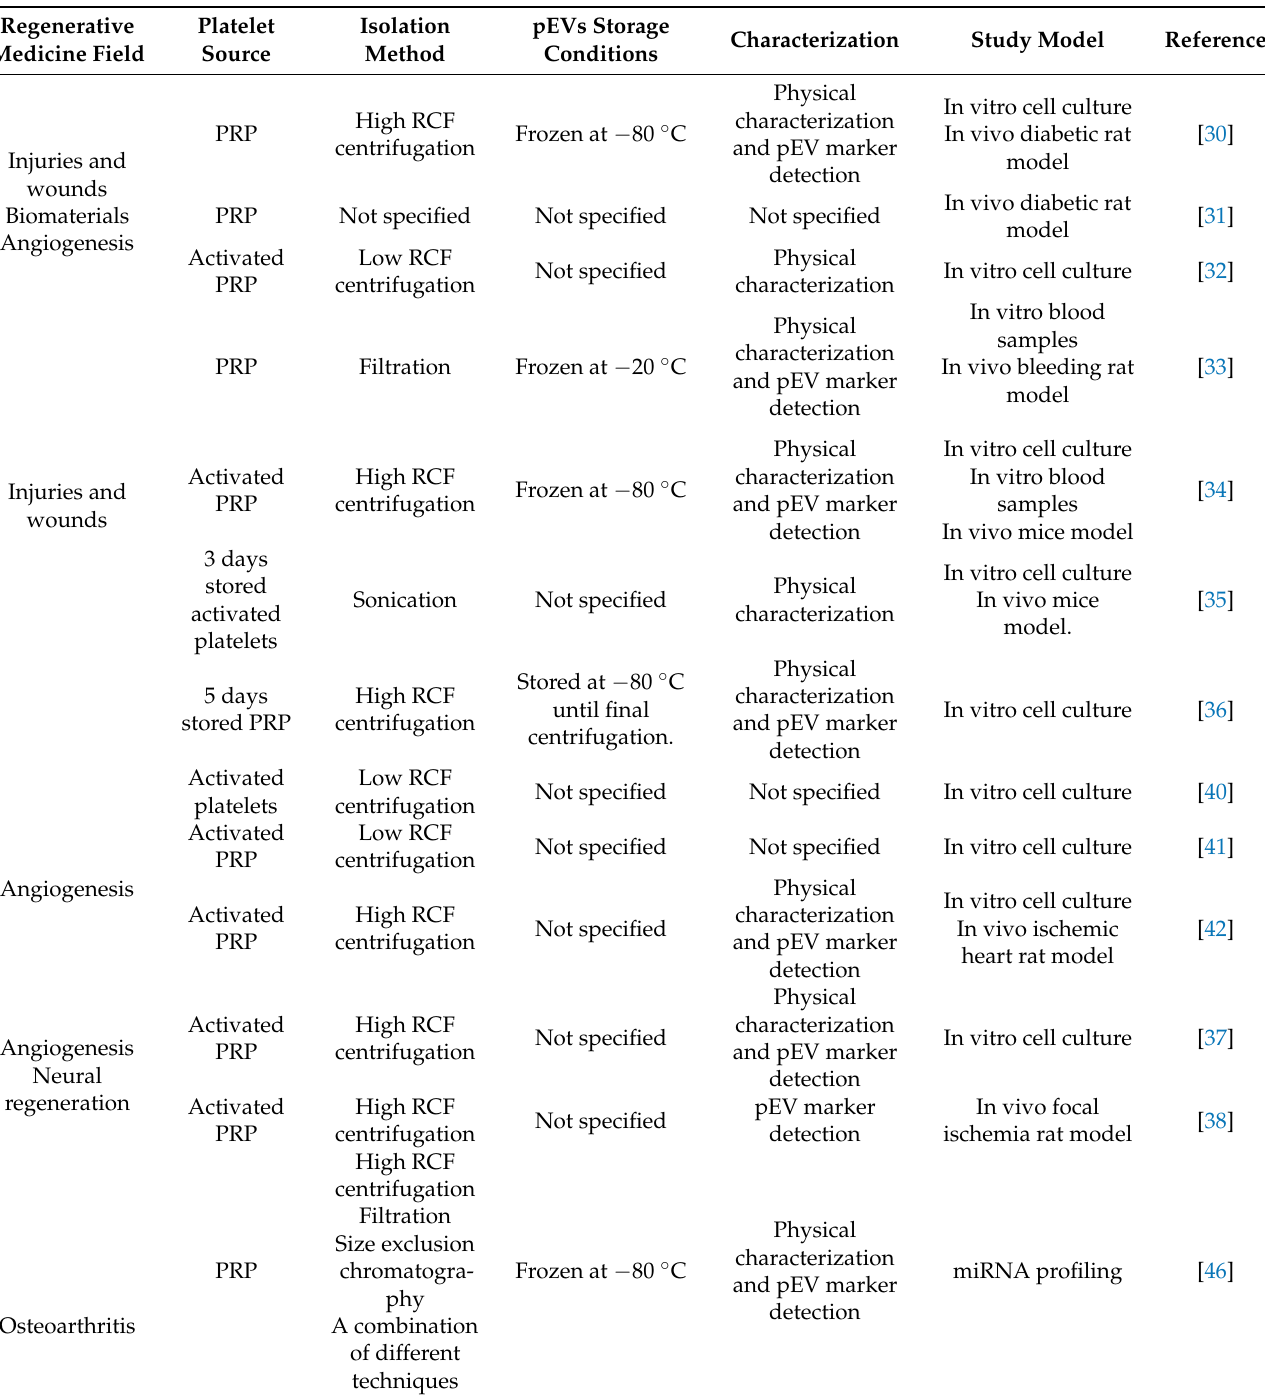
Table 1. Main pEVs regenerative medicine studies, with their platelet source, isolation method, storage conditions, characterization performed, and study